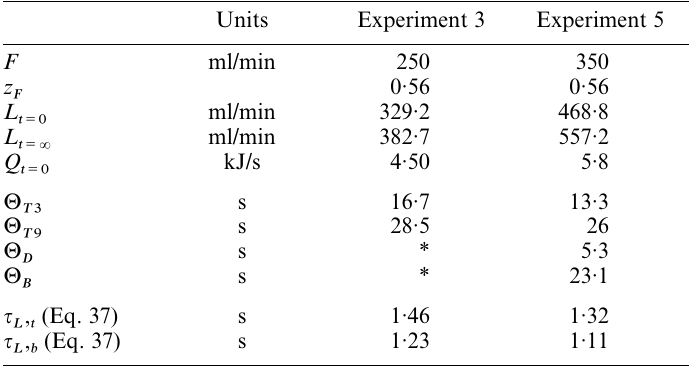
Table 4. Experiments 3 and 5 for changes in liquid flows. Experimental conditions, measured time delays ( h ), and hydraulic time constant ( q L